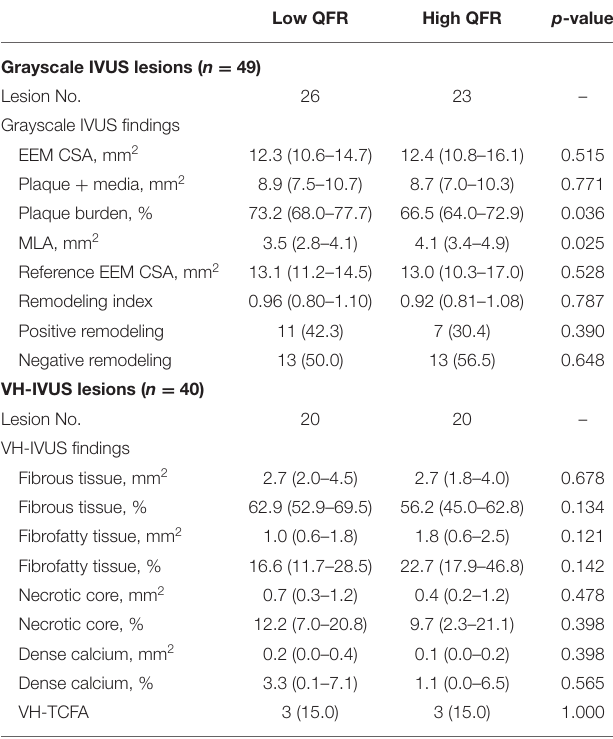
TABLE 3 | IVUS characteristics according to QFR